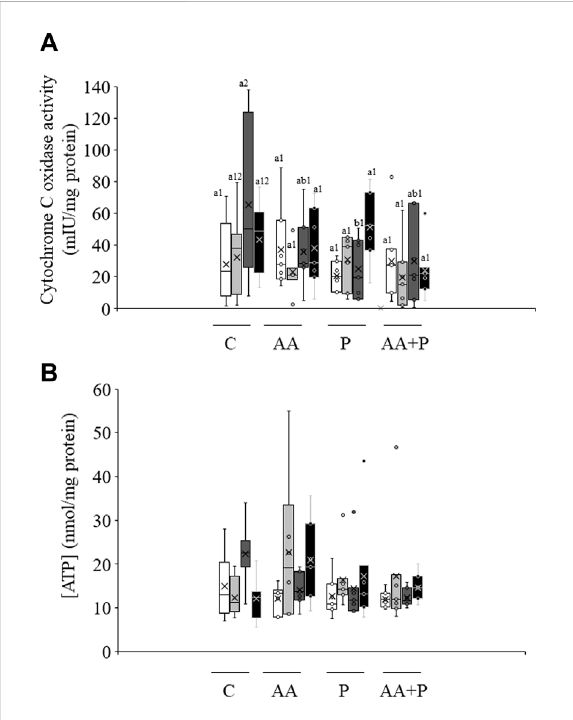
FIGURE 4 Box-and-whisker plot of the effects of antimycin A and PKCi on intracellular ATP levels and totalcytochrome C oxidase activity. SpermweresubjecttoseparateredLEDlightirradiationpatternsin the presence of 1 µM antimycin A, 100 nM PKCi or both together, before intracellular ATP levels and cytochrome C oxidase activity were evaluated as described in Materials and Methods section. Sperm were not irradiated (white boxes) or irradiatedwithredLEDlightfor1 min(lightgreyboxes),5 min(dark grey boxes) or 10 min (black boxes) in the absence (C) or presence of 1 µM antimycin A (AA), 100 nM PKCi (P) or 1 µM antimycin A and 100 nM PKCi together (AA + P). (A) intracellular ATP levels. (B) cytochrome C oxidase activity. Figure shows means ± S.E.M. for eight biological replicates involving eight independent samples. Asterisks inside boxes indicate means, whereas lines inside represent medians. In Figure 4A, different superscript numbers indicate signi fi cant ( p < 0.05) differences between samples pre- incubated with the same inhibitor (i.e., Control, antimycin A, PKCi or antimycin A + PKCi) but subject to distinct irradiation patterns (i.e., 0, 1, 5 or 10 min). Different superscript letters indicate signi fi cant ( p < 0.05) differences between samples incubated with separate inhibitors (Control, antimycin A, PKCi, or antimycin A